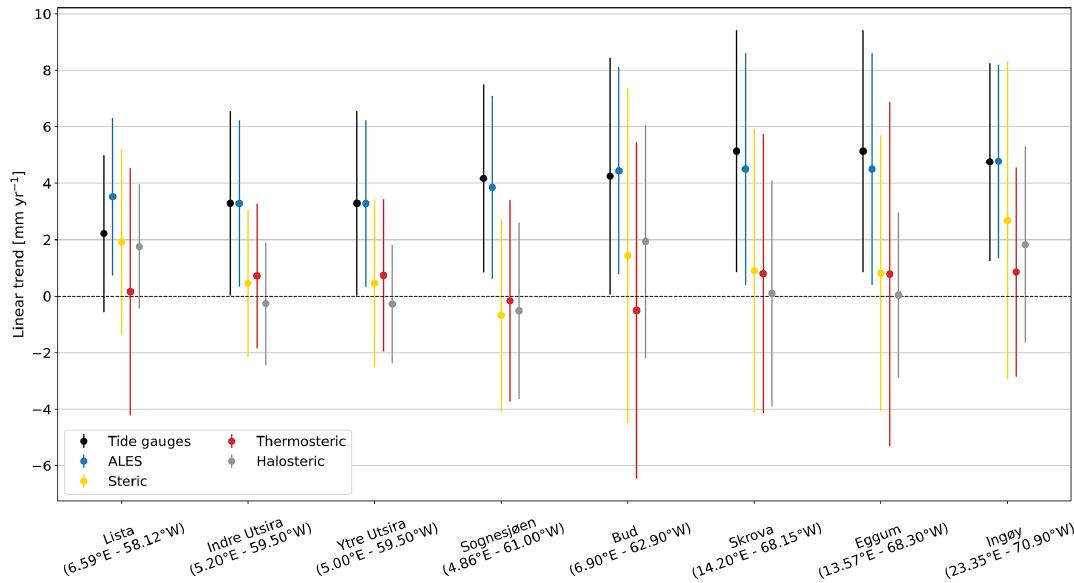
Figure 12. At each hydrographic station, the linear trend of the sea level from tide gauges and from ALES (black and blue dots, respectively), as well as of the steric, thermosteric, and halosteric components of the sea level (yellow, red, and gray dots, respectively). The bars indicate the 95% confidence